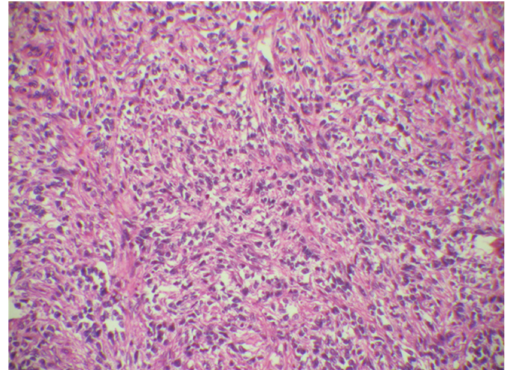
Figure 6: Adenosarcomatous overgrowth area in adenosarcoma: Stromal cells are large and